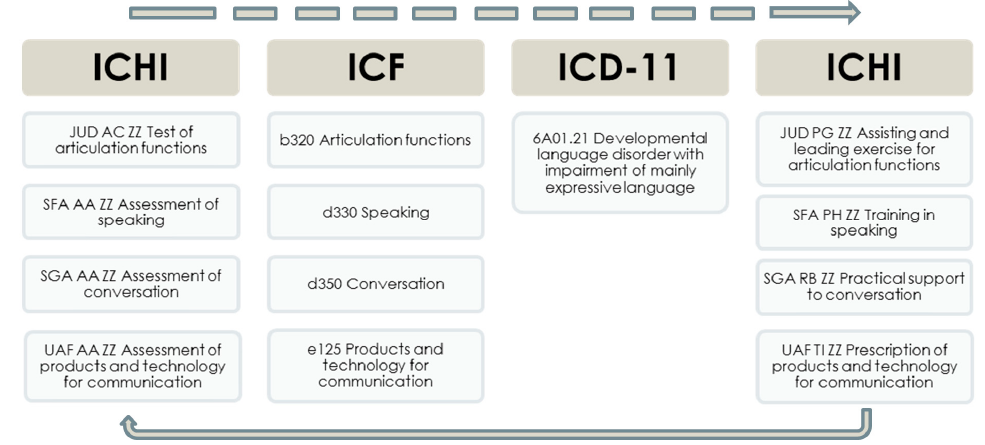
Figure 2. Using the three WHO classifications together—example of coding for interventions, level of functioning, functioning goals and diagnosis relevant to a person with communication-related functioning limitations.